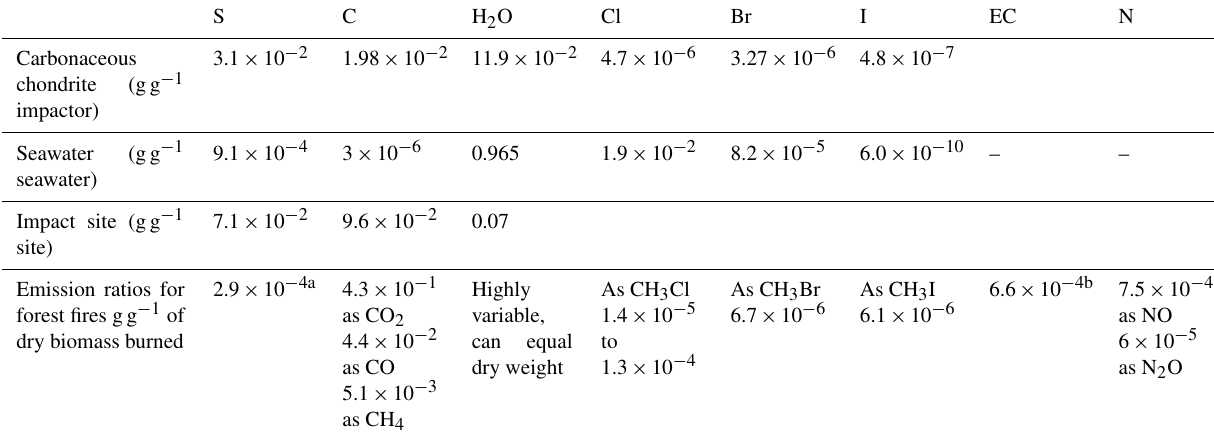
Table 6. Impactor composition, seawater composition, Yucatan impact site composition, and forest fire emission ratios. S